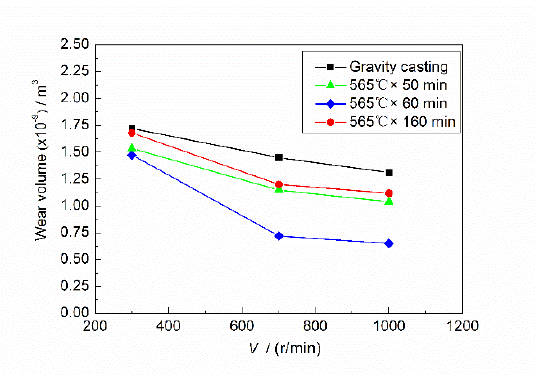
Figure 7. Curves of Mg 2 Si–Al composites between wear volume and sliding velocity.